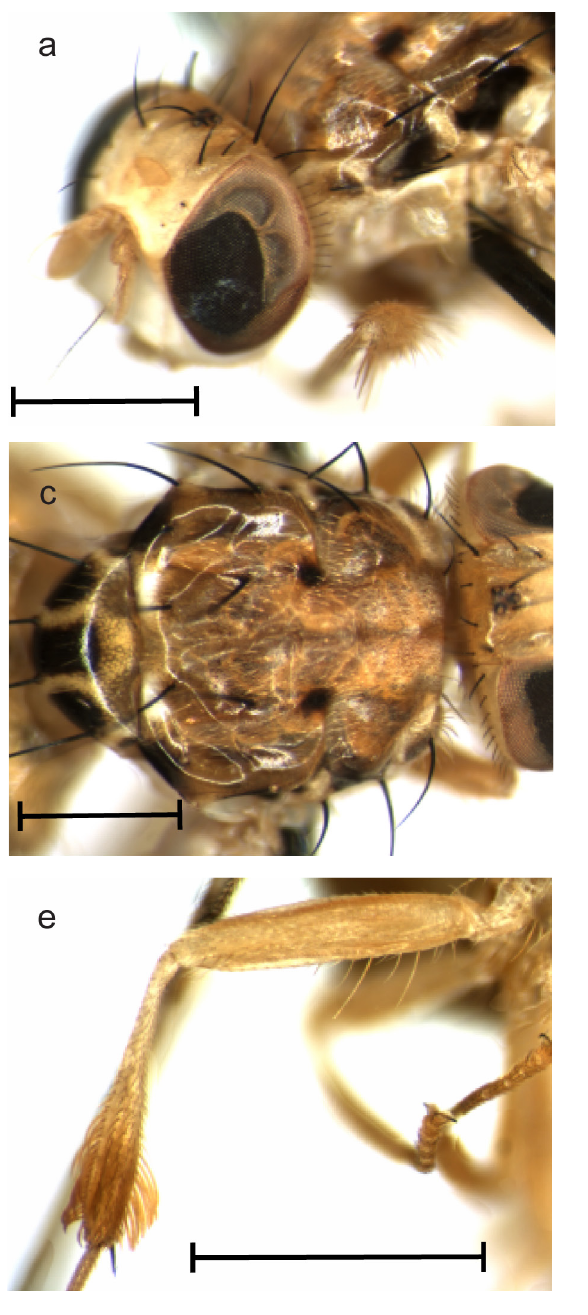
Fig. 5. Ceratitis flavipennata De Meyer & Virgilio sp. nov. a . Head and thorax, anterodorsal view. b . thorax, lateral view. c . thorax, dorsal view. d . abdomen, dorsal view. E . Midleg, anterior view. F . wing. Scale bars = 1